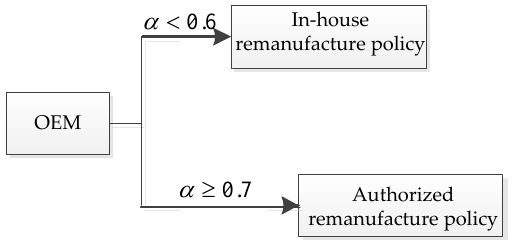
Figure 25. The effect of the green consumers on OEMs’ remanufacturing strategies.